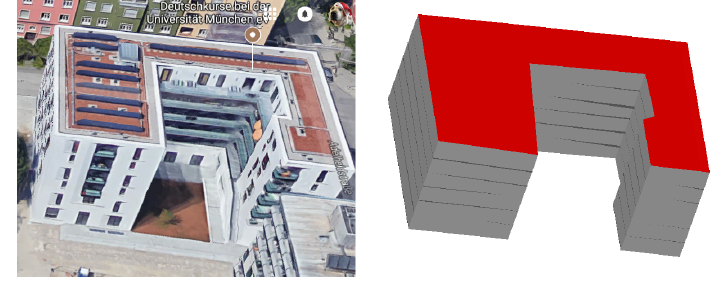
Figure A2. Final CityGML level of detail two plus (LoD2+) model for Building B.